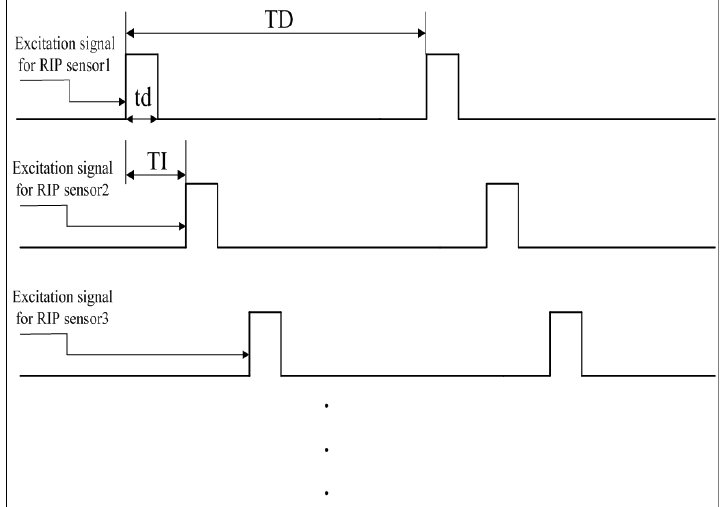
Figure 2. Description of how TDM works in the RIP